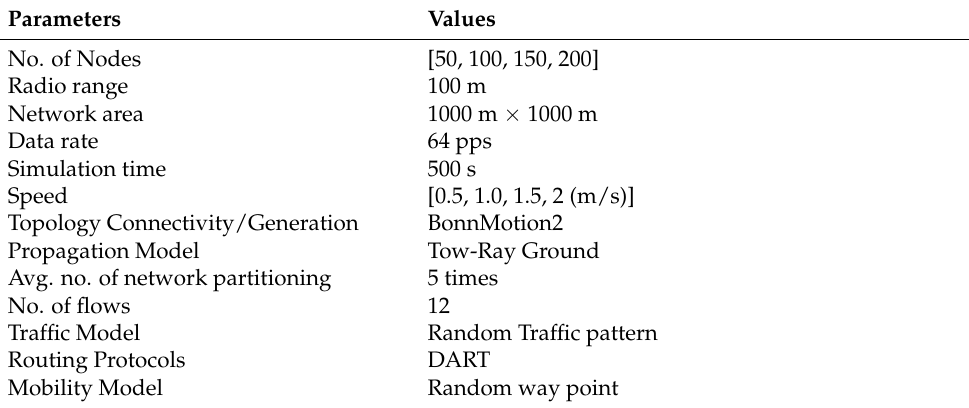
Table 2. Simulation